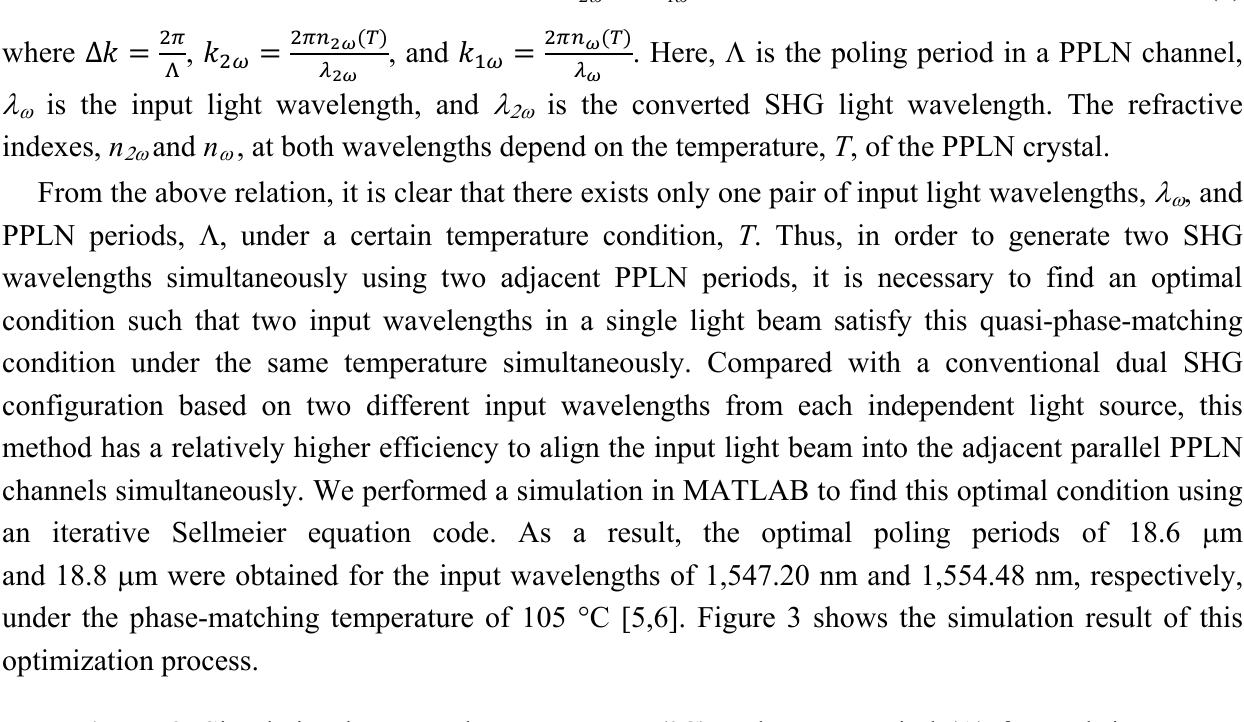
Figure 3. Simulation between the temperature (°C) and PPLN period (  ) for each input wavelength of (a) 1,547.20 nm and (b) 1,554.48